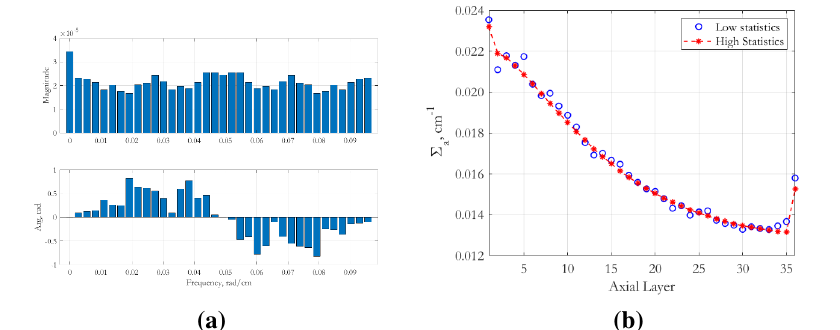
Figure 6: (a) Transfer Functions calculated at ρ